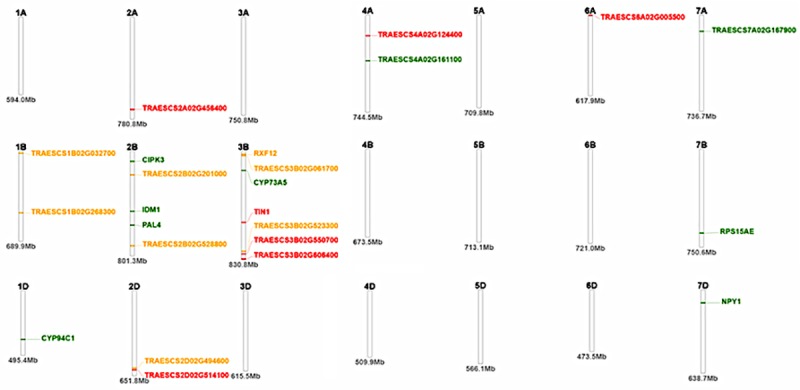
Physical map of the wheat genome showing the positions of the identified genes localized with the some of the SNP markers.TRAESCS2B02G321800 = IDM1, TRAESCS2B02G114000 = CIPK3, TRAESCS2B02G398200 = PAL4, TRAESCS3B02G154000 = CYP73A5, TRAESCS2D02G370400 = ABCG11, TRAESCS4D02G238900 = WAKL21, TRAESCS5B02G236600 = AMY1, TRAESCS7B02G377800 = RPS15AE, TRAESCS1D02G276600 = CYP94C1, TRAESCS7D02G150700 = NPY1, TRAESCS4D02G272500 = PSAT2, TRAESCS1B02G340800 = FH6, TRAESCS3B02G045600 = RXF12, TRAESCS3B02G337500 = TIN1.